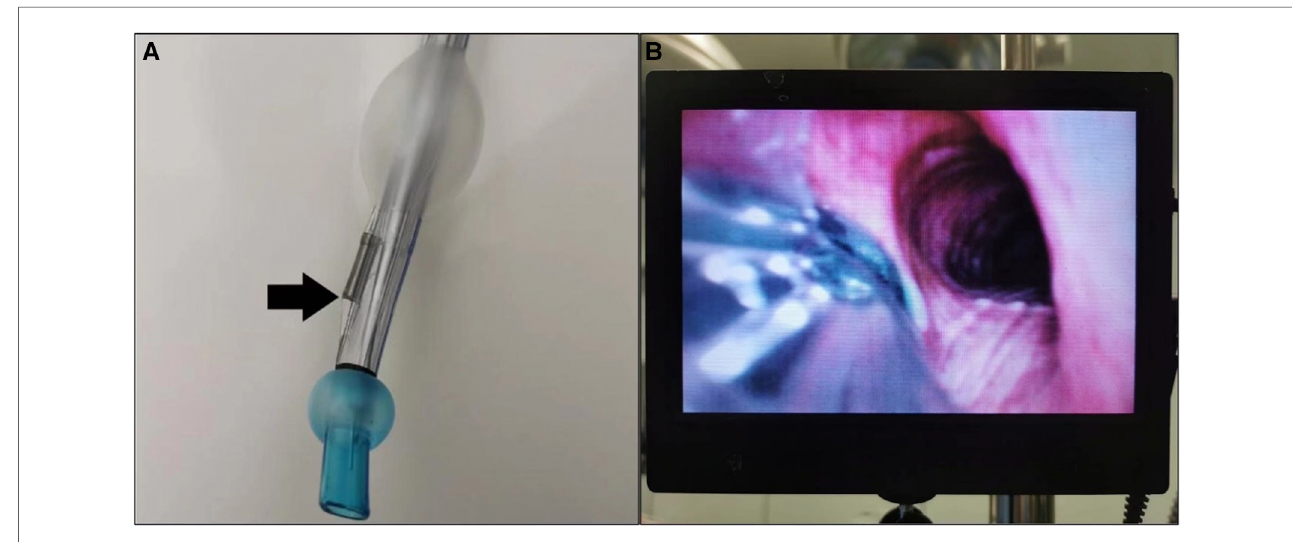
FIGURE 1 ( A ) Video-assisted DLT (well lead medical Co. Ltd.). The arrow indicates the optical sensor, which is licated at the junction of the tracheal and bronchial lumens. ( B ) An external display connected with VDLT, which can continuously dis-play the position of the tube in the